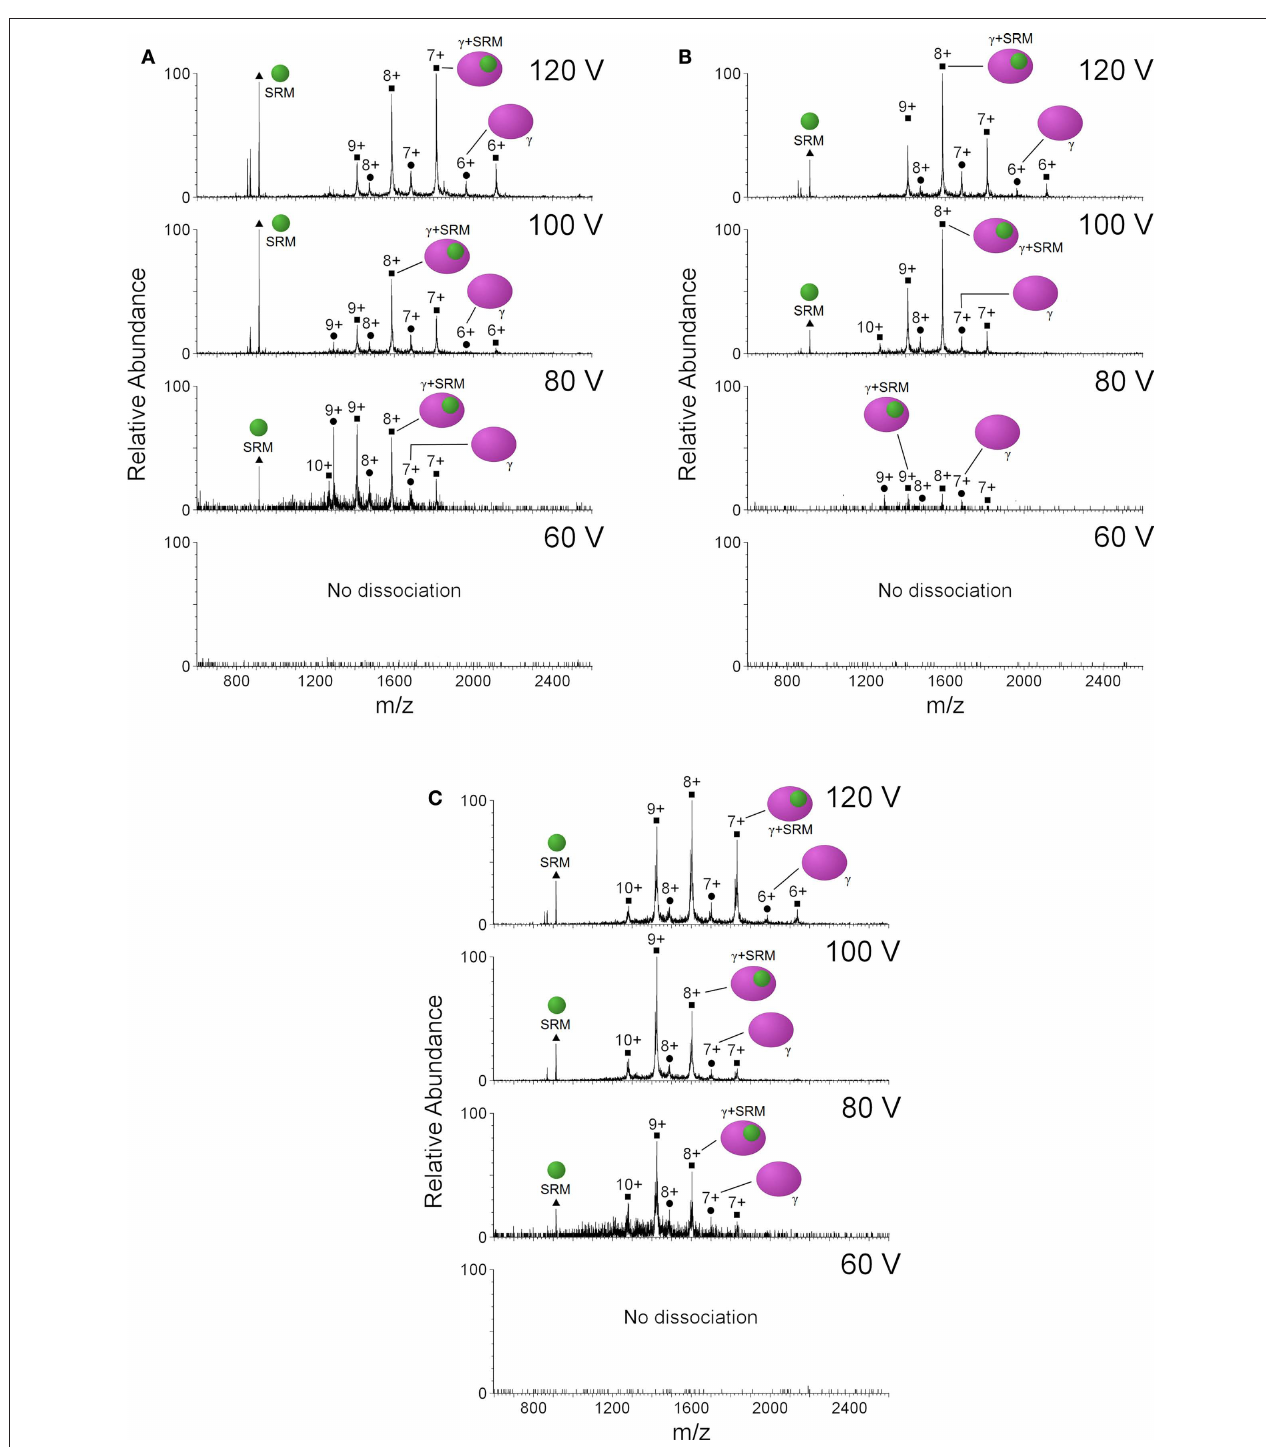
Figure 6 | Nano-eSi/MS spectra of (A) band 1 and (B) band 2 from dSir D. norvegicum and for (C) band 1 from D. vulgaris , showing the presence of isolated DsrC and SrM and DsrC-SrM complex. Schematic representation of (DsrC) as magenta and siroheme (SRM) as